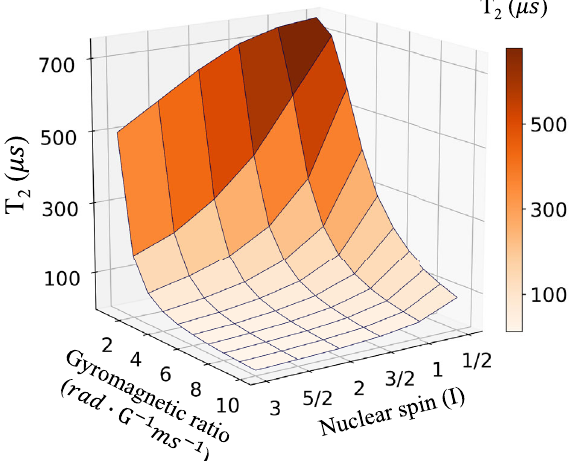
Fig. 3 Hypothetical T 2 of V B − in h-BN. Computed T 2 as a function of the gyromagnetic ratio and nuclear spin number of 10 B in h- 10 B 14 N. An external magnetic fi eld of 3 T is